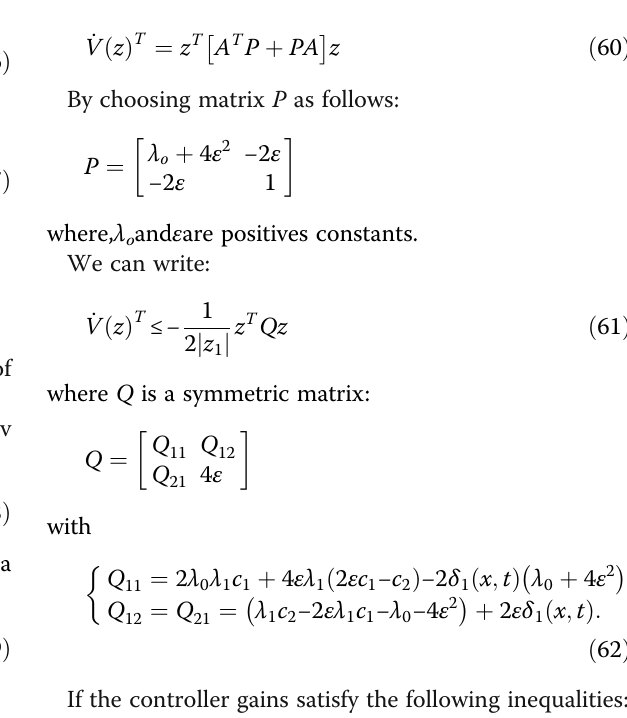
Fig. 10 WT rotor speed tracking: reference (red) and real (blue)